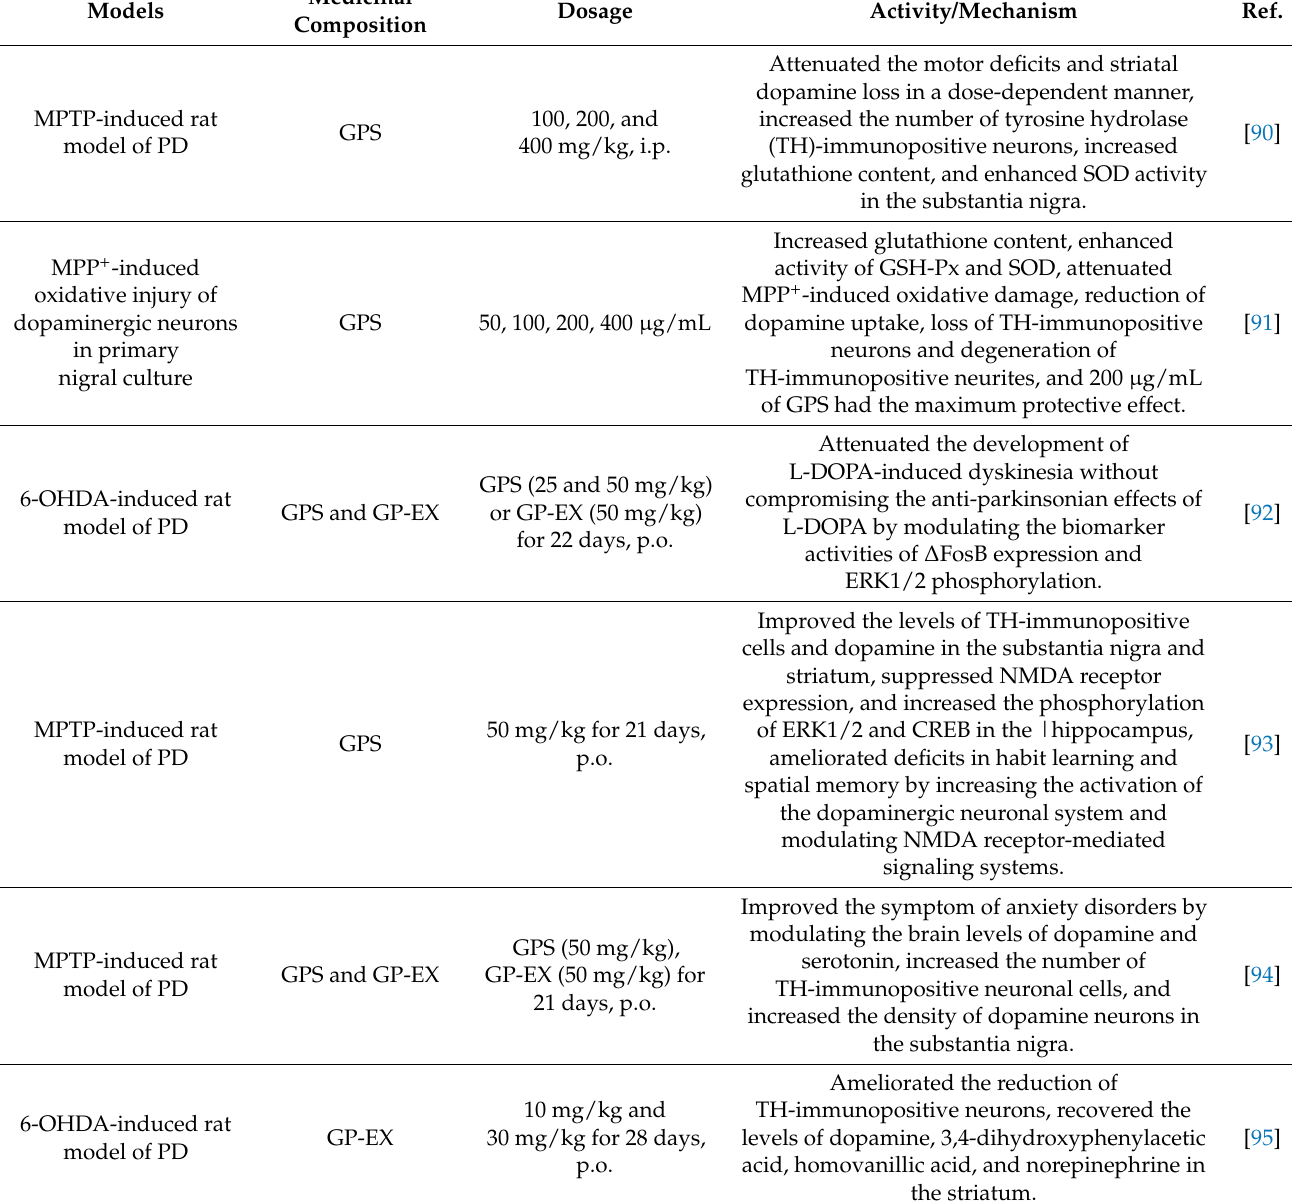
Table 3. Anti-Parkinson’s disease effect of